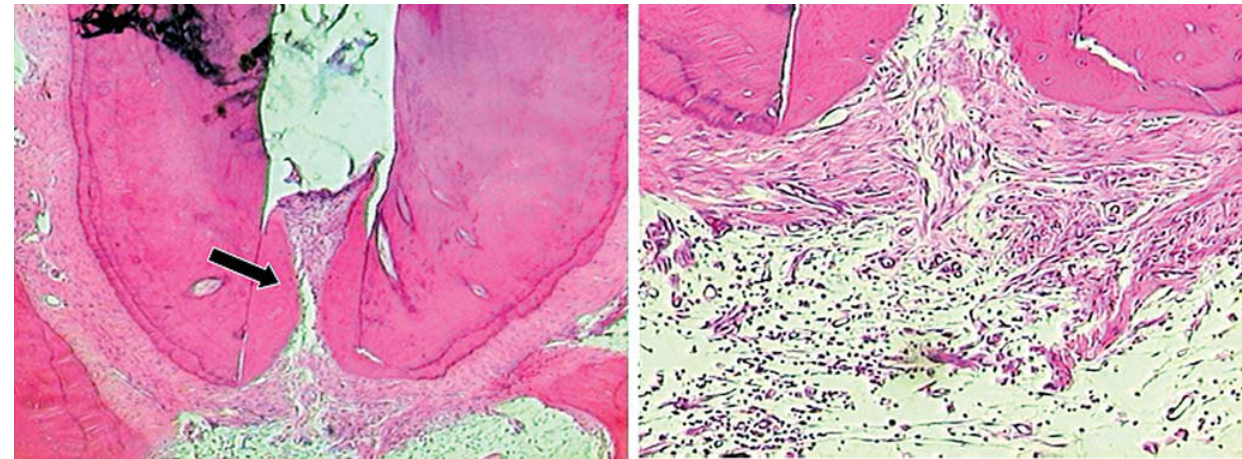
FIGURE 1 - A – SEM micrograph of apical and periapical regions of a specimen in the AH Plus group. Observe newly formed hard tissue deposition (arrow), followed by an organized periodontal ligament. HE. 40X. B – Close-up view. Observe sparse mononuclear cells, compatible with score 2 of AIR. HE. 100X